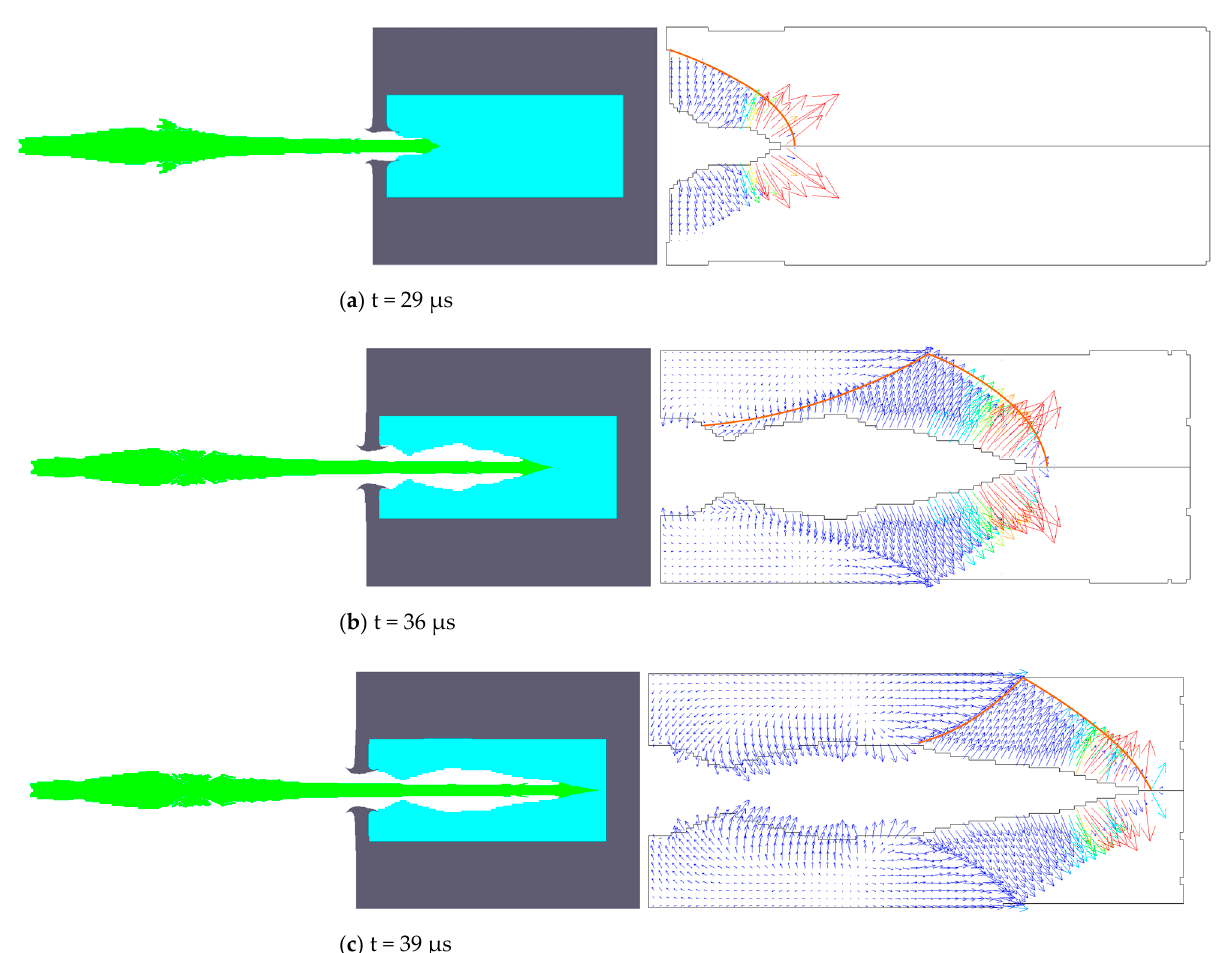
Figure 9. Generation and propagation of the initial shock wave and side-wall reflection shock wave (the orange curve represents the shock wave front).